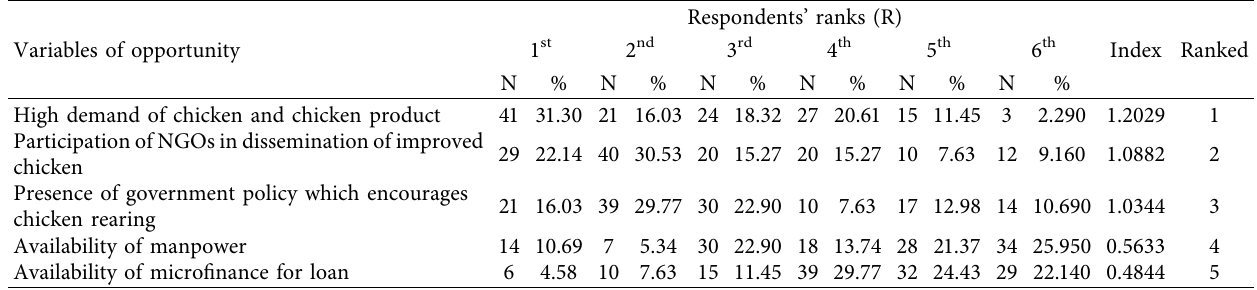
Table 5: Opportunities of improved chicken production in the study